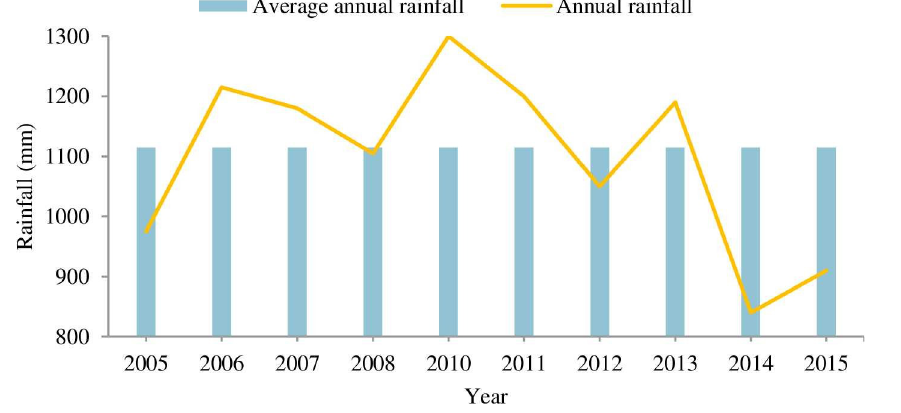
Fig 5. Variations of average annual